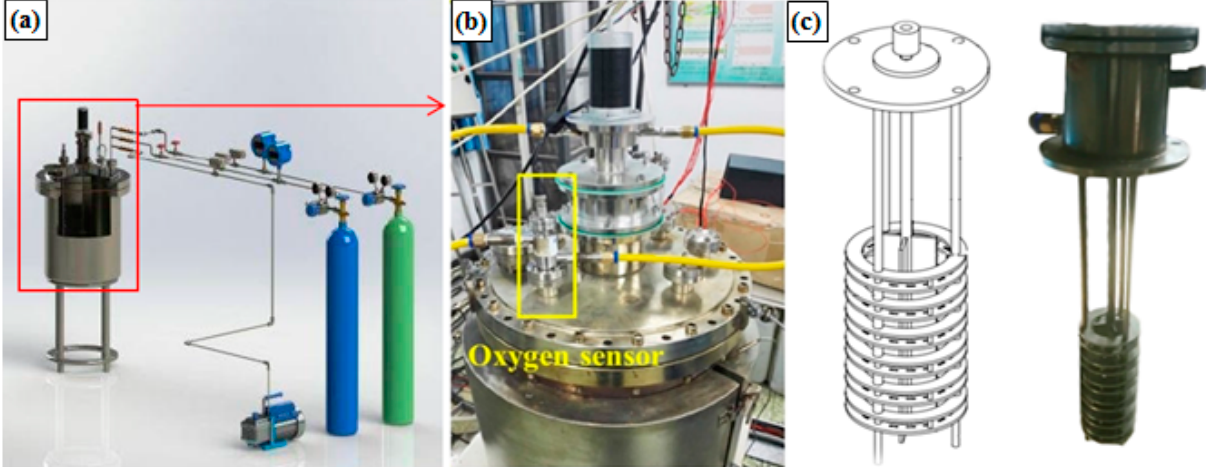
Figure 1. Schematic illustration of the pot-type multifunctional LBE corrosion platform: ( a ) corrosion tank, ( b ) the structure of oxygen sensor and ( c ) specimen holder.